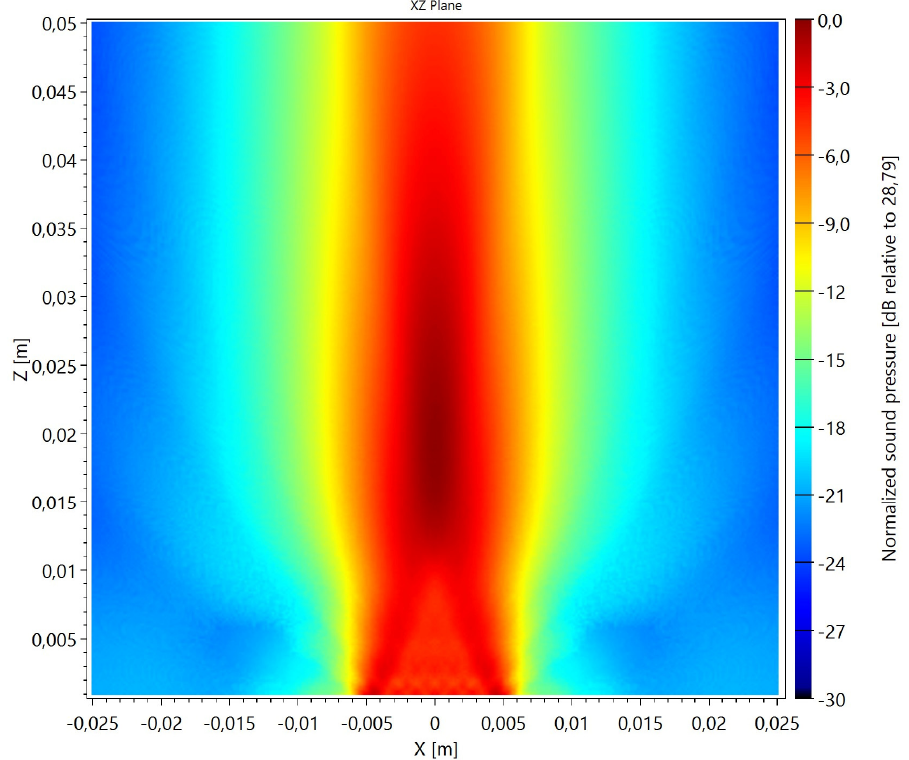
Figure 4. The simulated acoustic pressure distribution of a single array element for a speed of sound of approximately 2500 m/s in bone.